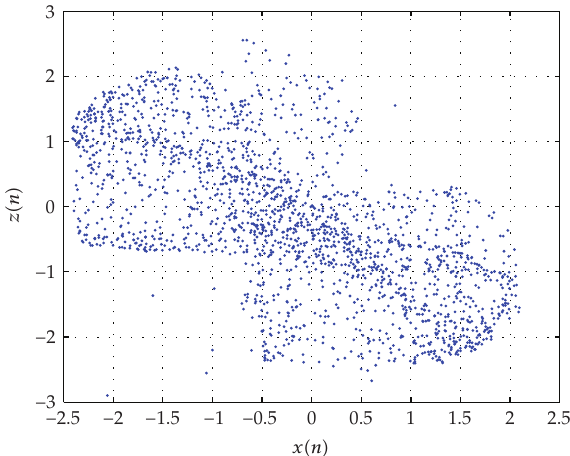
Figure 6: Phase portrait of the chaotic attractor (cid:5) x n ,z n (cid:6) .